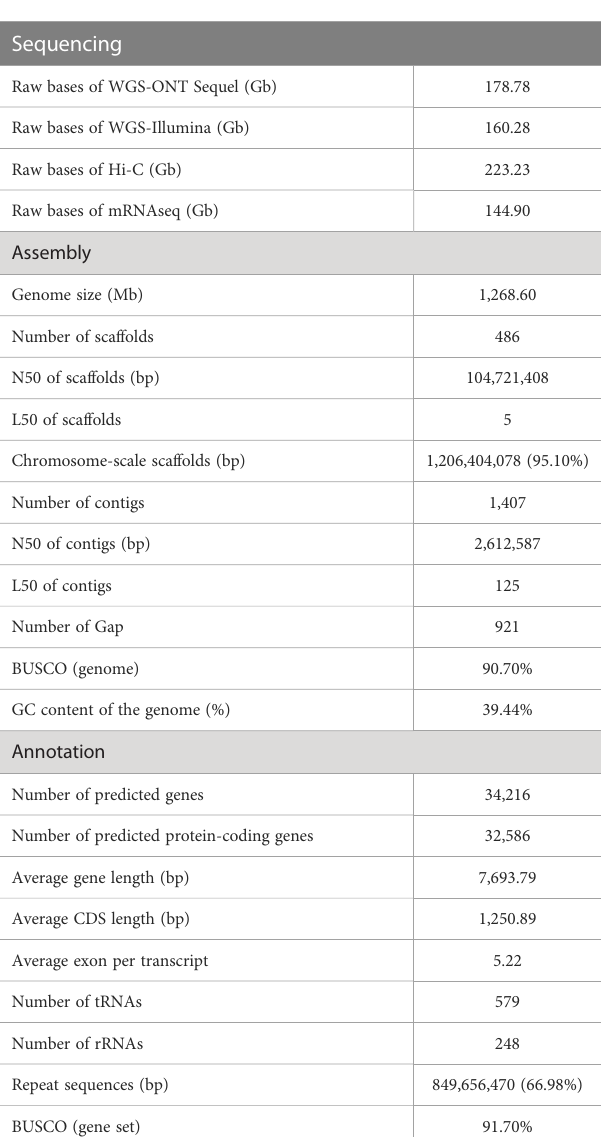
TABLE 1 Statistics of the Lindera megaphylla genome assembly and